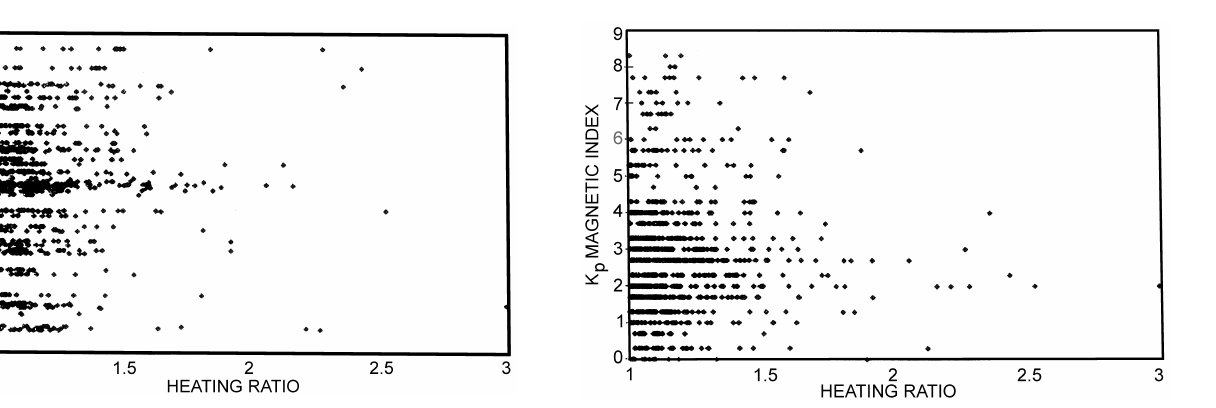
6 as a function of the Kp geomagnetic index. the unadjusted level of Joule heating are shown in Fig. 5 as a function of altitude for local noon and midnight. Increases of 10–20 K and ∼ 5 K are observed throughout the F-region during the night and day, respectively, for (cid:15) 6 = 1 . 4. When (cid:15) 6 = 1 . 2, there is a slight cooling at all F-region altitudes. Below 150 km all traces show a modest increase in temper- ature. The changes in temperature correspond to changes of up to about